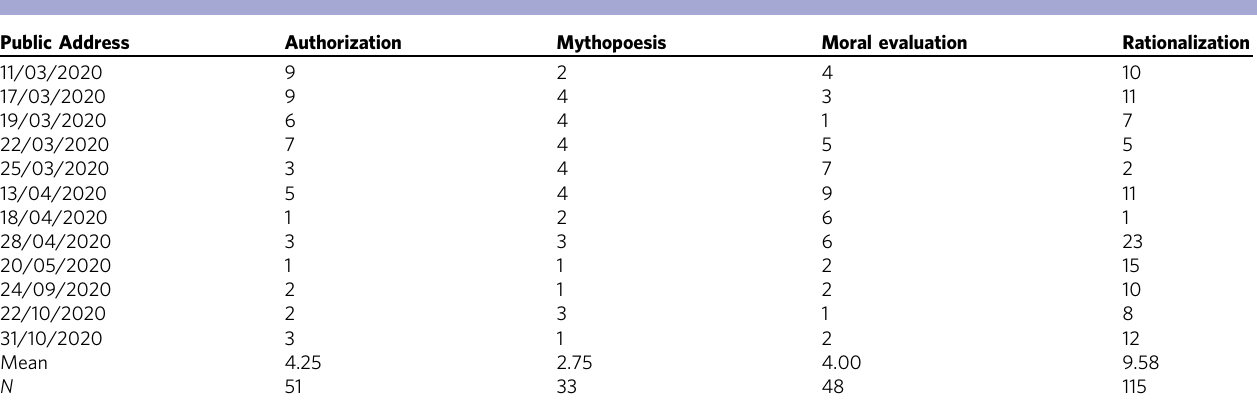
Table 4 Illustrative quotes for the “ rationalization ” permeating K. Mitsotakis ’ discourse. Q1: We are adding beds and intensive care beds, we are buying respirators and consumables. And we hire 2000 nurses and specialists ” (19/03/2020). Q2: “ We used the summer to shield the National Health System, which from 557 ICU beds last year has almost 1000 now; and stocks of sanitary supplies with a horizon of months. We have hired about 6200 new nurses and doctors, many of whom will remain permanently in the NHS ” (24/09/ 2020). Q3: “ It (the government) has spent more than 14 billion to support employees and businesses. And it secures another 10 billion euros in liquidity and additional European funds. Already, 750,000 workers are receiving the 800-euro boost. Nearly 200,000 unemployed had their bene fi ts extended. In more than 500,000 companies, all tax and insurance obligations have been suspended. And 85,000 scientists have applied for paid distance learning programs ” (13/04/2020).